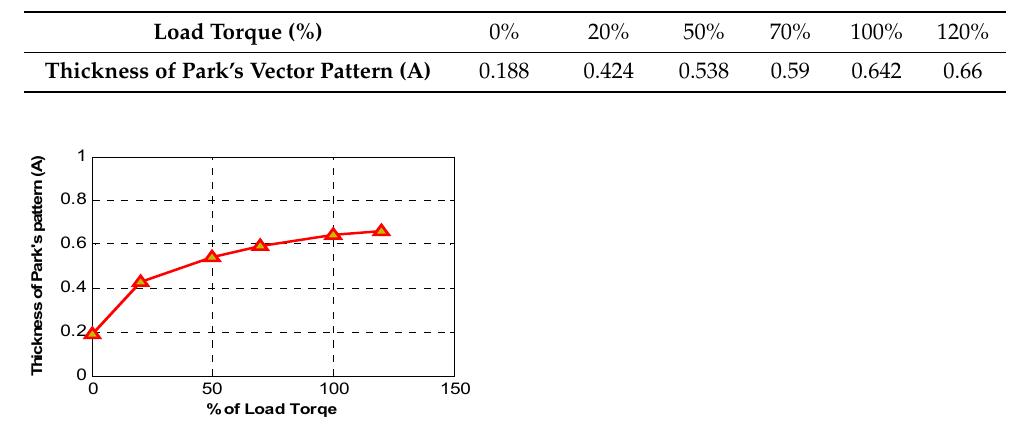
Figure 11. Park’s vector trajectories of a motor with BRB and under different load conditions: ( a ) unloaded motor, ( b ) under 20% of nominal load, ( c ) under 50% of nominal load, ( d ) under 70% of nominal load, ( e ) under 100% of nominal load, and ( f ) under 120% of nominal load. Table 3. The thickness of the Park’s vector pattern of a motor with BRB and under different load conditions.